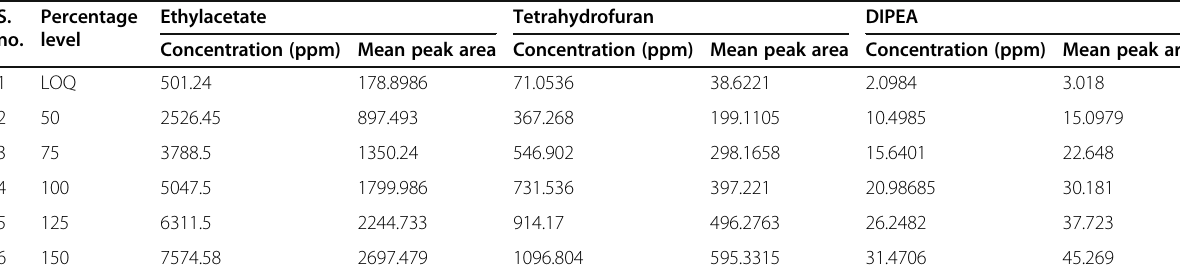
Table 7 Linearity and range of solvents S. Percentage no. level